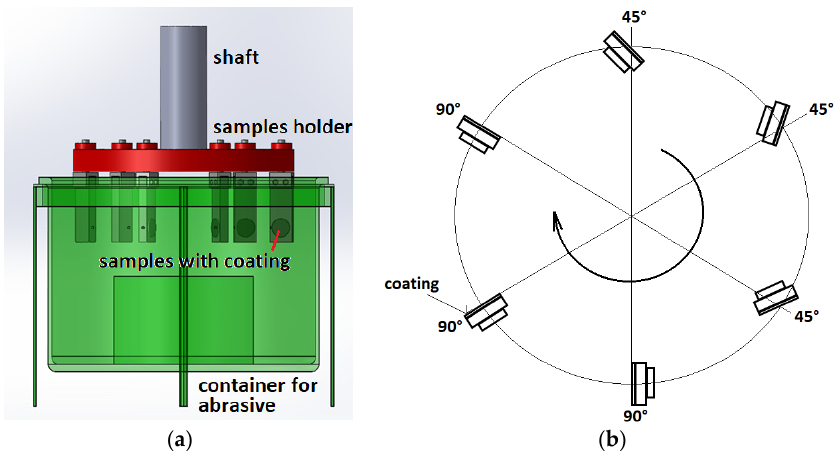
Figure 1. ( a ) Fixing of test samples in the testing device; ( b ) scheme of contact geometry.